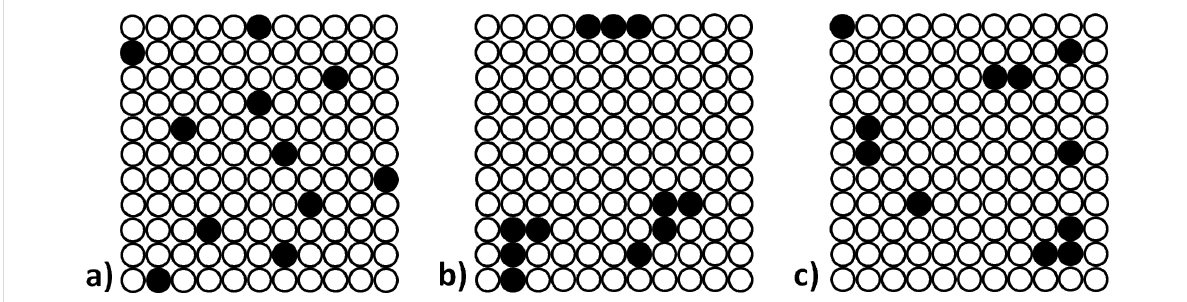
Figure 2: Indicative examples of the possible distribution of Mn 2+ dopant in zinc oxide crystalline lattice. Black circles: Mn 2+ dopant, white circles: ZnO. a) Unclustered distribution of dopant; b) clustered distribution of dopant; c) random distribution of dopant.